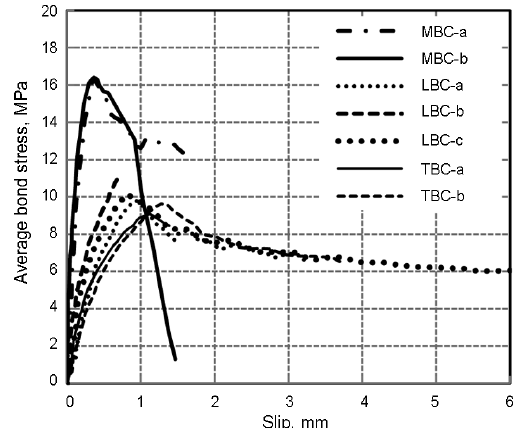
Fig. 5. Average bond stress-slip curves in specimens with CFRP bars bonded with epoxy